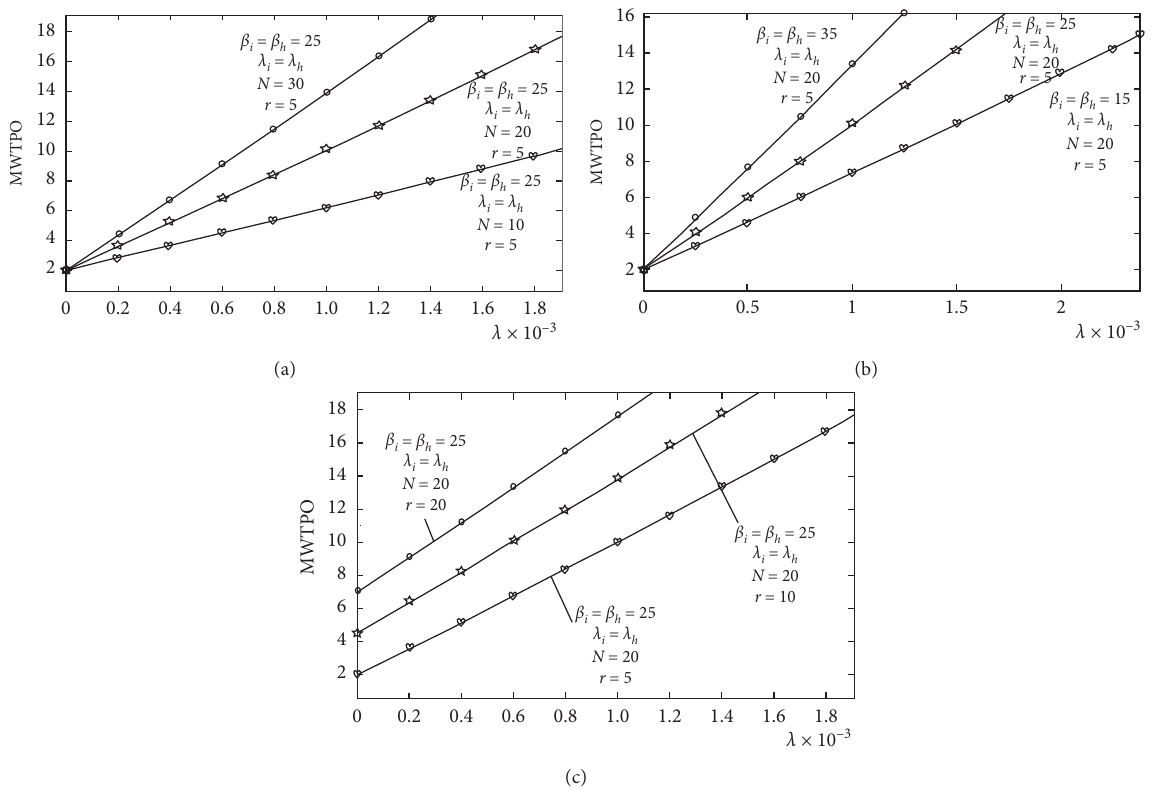
Figure 5: The change trend of MWTPO. (a) Range of MWTPO with λ ′ s change under different N. (b) Range of MWTPO with λ ′ s change under different β. (c) Range of MWTPO with λ ′ s change under different r .